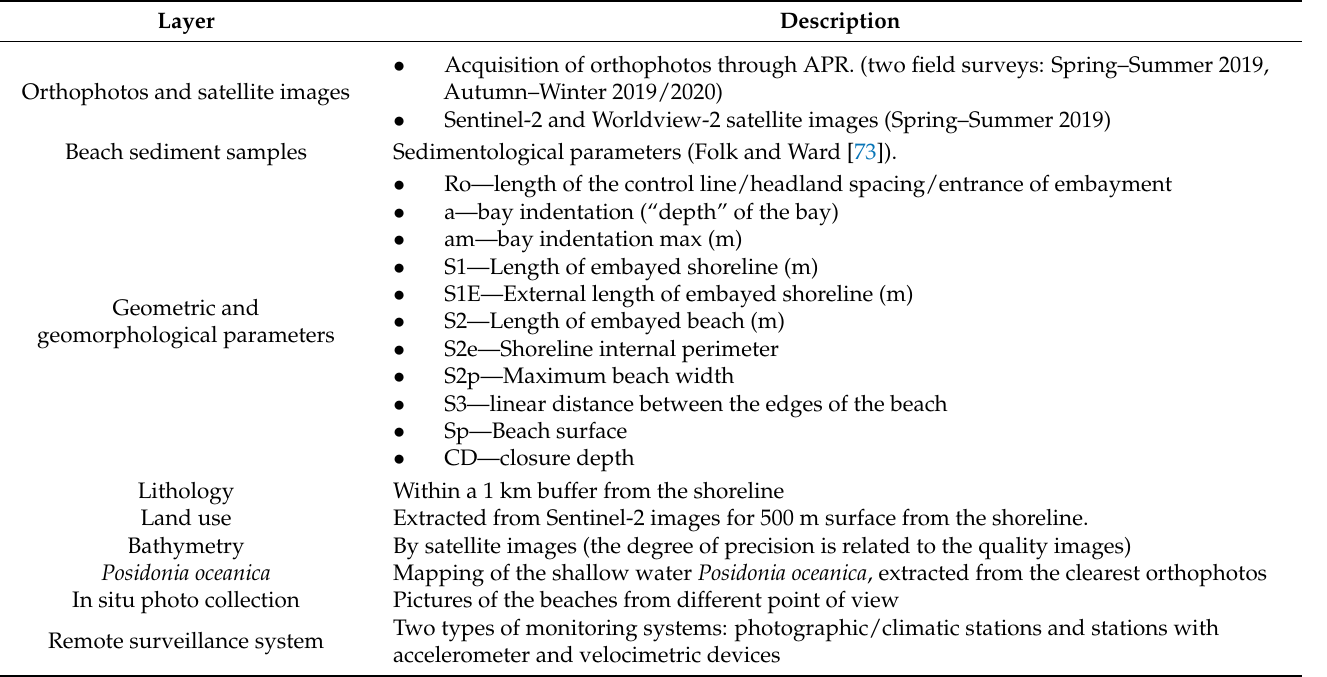
Table A1. Summary table of the layers/data present in the